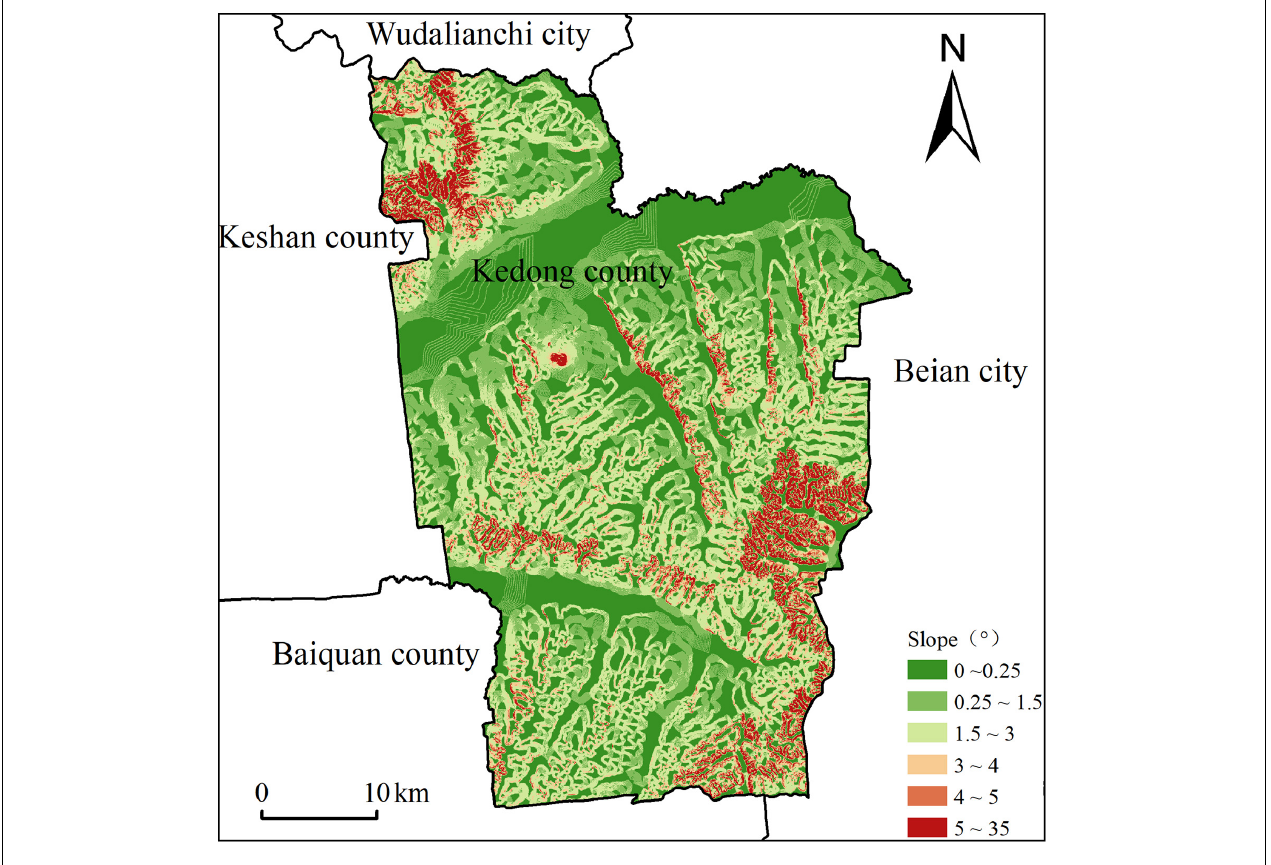
FIGURE 2 | Slope classification map. TABLE 1 | Sources of the slope, gully, and land use maps indicating their respective spatial